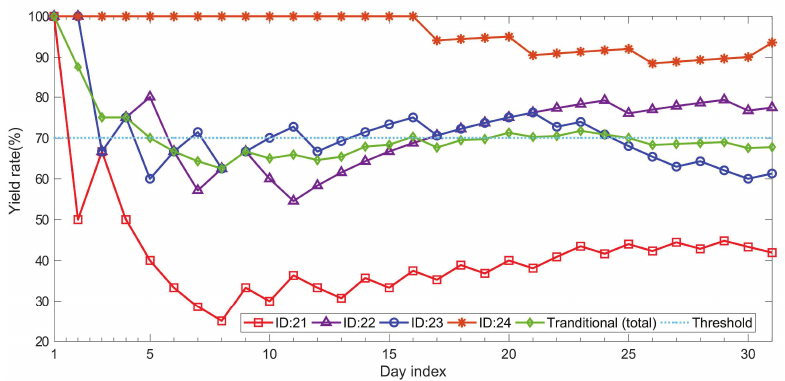
Figure 7. Individual vs. group yield